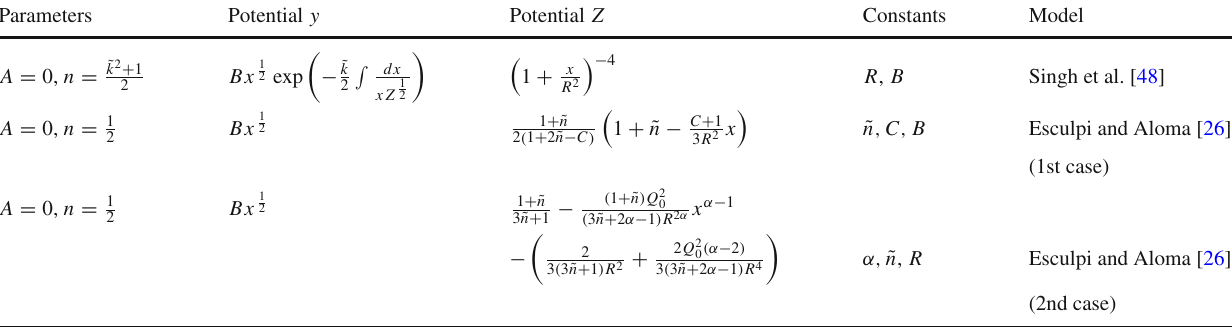
Table 2 Exact charged anisotropic conformal symmetry solutions contained in our model Parameters